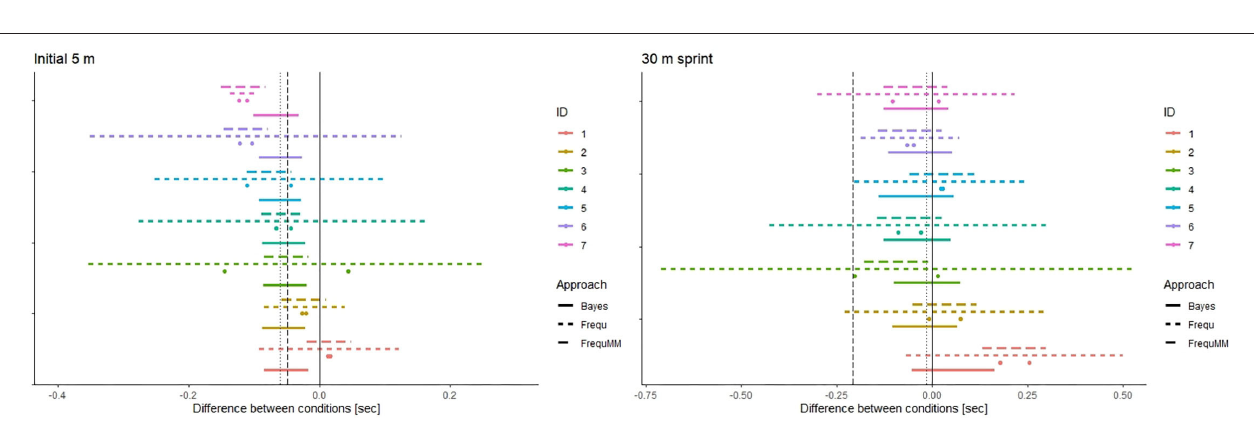
FIGURE 4 | Efficacy of cold-water immersion on the individual level. 95% Bayesian credible intervals (highest posterior density intervals, Approach = Bayes) and 95% frequentist confidence intervals (Approach = Frequ), respectively. Intervals calculated from individual means and the (group-based) standard error for the fixed effect (Approach = FrequMM) are displayed for comparison. Points are observed differences in pre-post changes between conditions. HPDI have been calculated with informative priors. Subjects are ordered by posterior β CWI for 5m acceleration. Dashed vertical line: prior mean, Dotted vertical line: data mean, Solid vertical line: Zero Bayesian credible intervals and frequentist confidence intervals calculated with the same data are displayed in one figure for comparison. Please keep in mind their fundamental